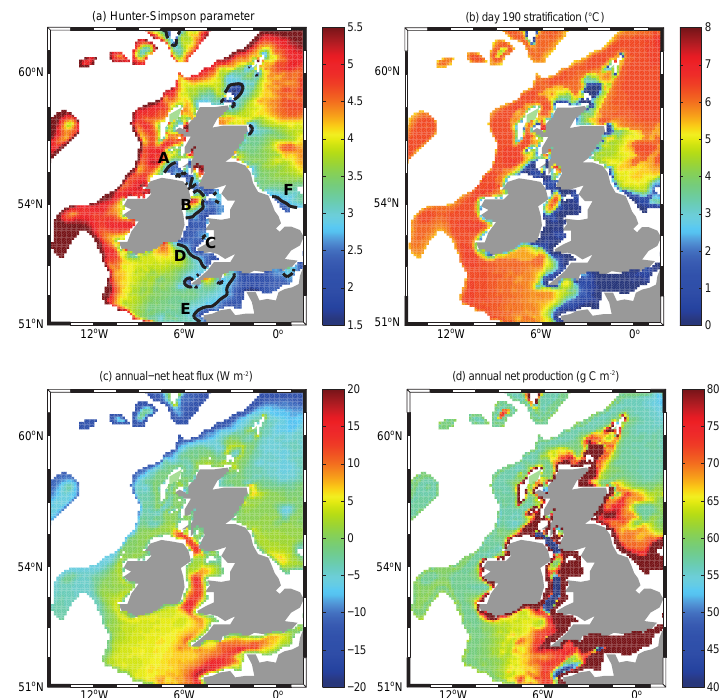
Figure 3. For the northwest European shelf domain: (a) Hunter–Simpson parameter, highlighting the contour delineating log 10 (h/u 3 ) = 2 . 7; (b) day 190 surface–bottom temperature difference; (c) net surface heat flux; (d) annual net production. In (a) , we label fronts as in Fig. 8.1 of Simpson and Sharples (2012): the Islay front (A); the western Irish Sea front (B); the Cardigan Bay front (C); the St. Georges Channel front (D); the Ushant and western English Channel front (E). We additionally label the Flamborough frontal system